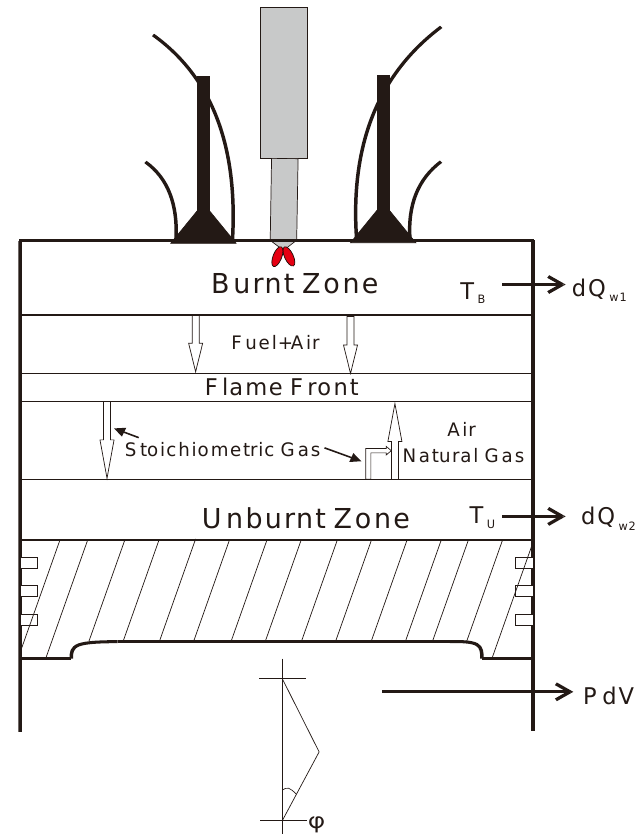
Figure 2. Schematic diagram of the two-zone model.